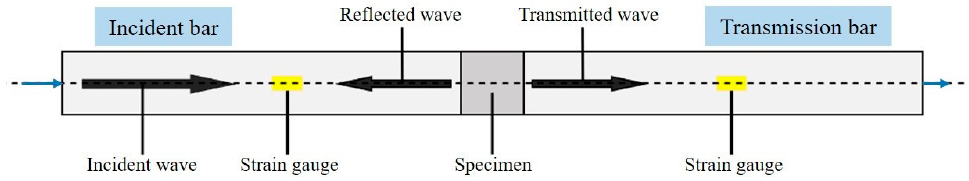
Figure 4. Schematic diagram of stress wave propagation.